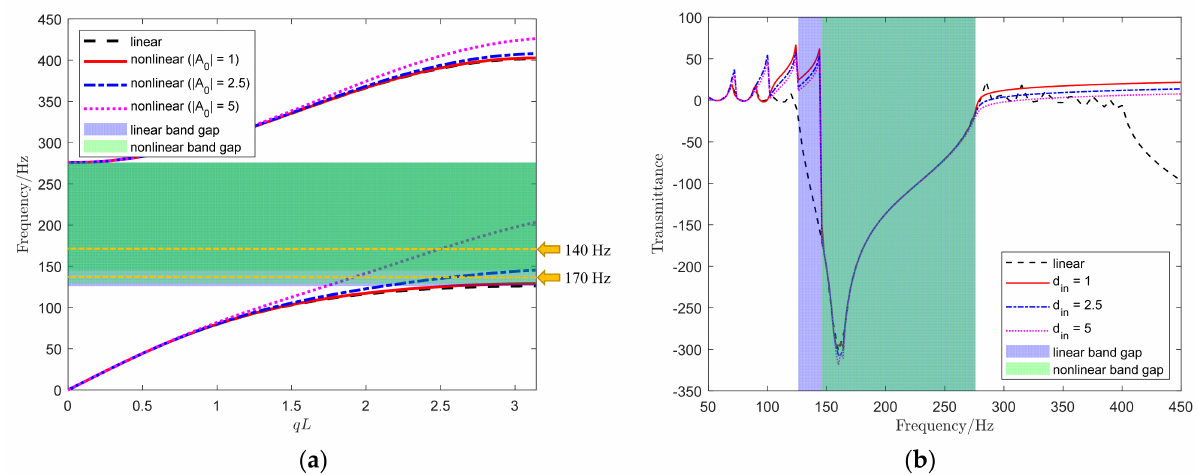
Figure 9. ( a ) Dispersion relations of a nonlinear phononic crystal with different wave amplitudes | A 0 | . ( b ) Transmit- tance of the structure modeled by COMSOL with different input displacements d in . The parameters are m 1 = 0.2 kg, k 1 = 2 × 10 5 N/m, m 0 = 0.1 kg, k 0 = 1 × 10 5 N/m, Γ = 1, and ε =